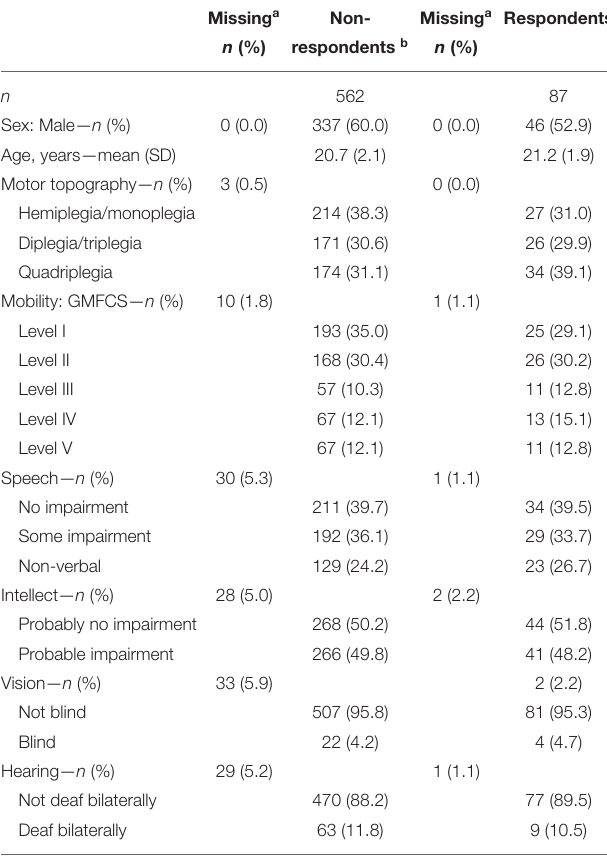
TABLE 3 | Comparison of the CP cohort with VCPR non-respondents. Missing